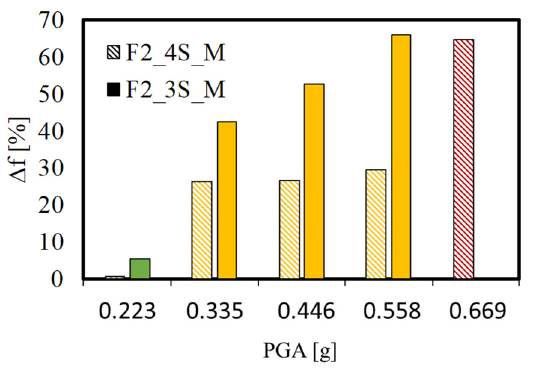
Figure 9. Comparison of F2_3S_M and F2_4S_M in terms of variation in in-plane natural frequency vs. PGA. vs.